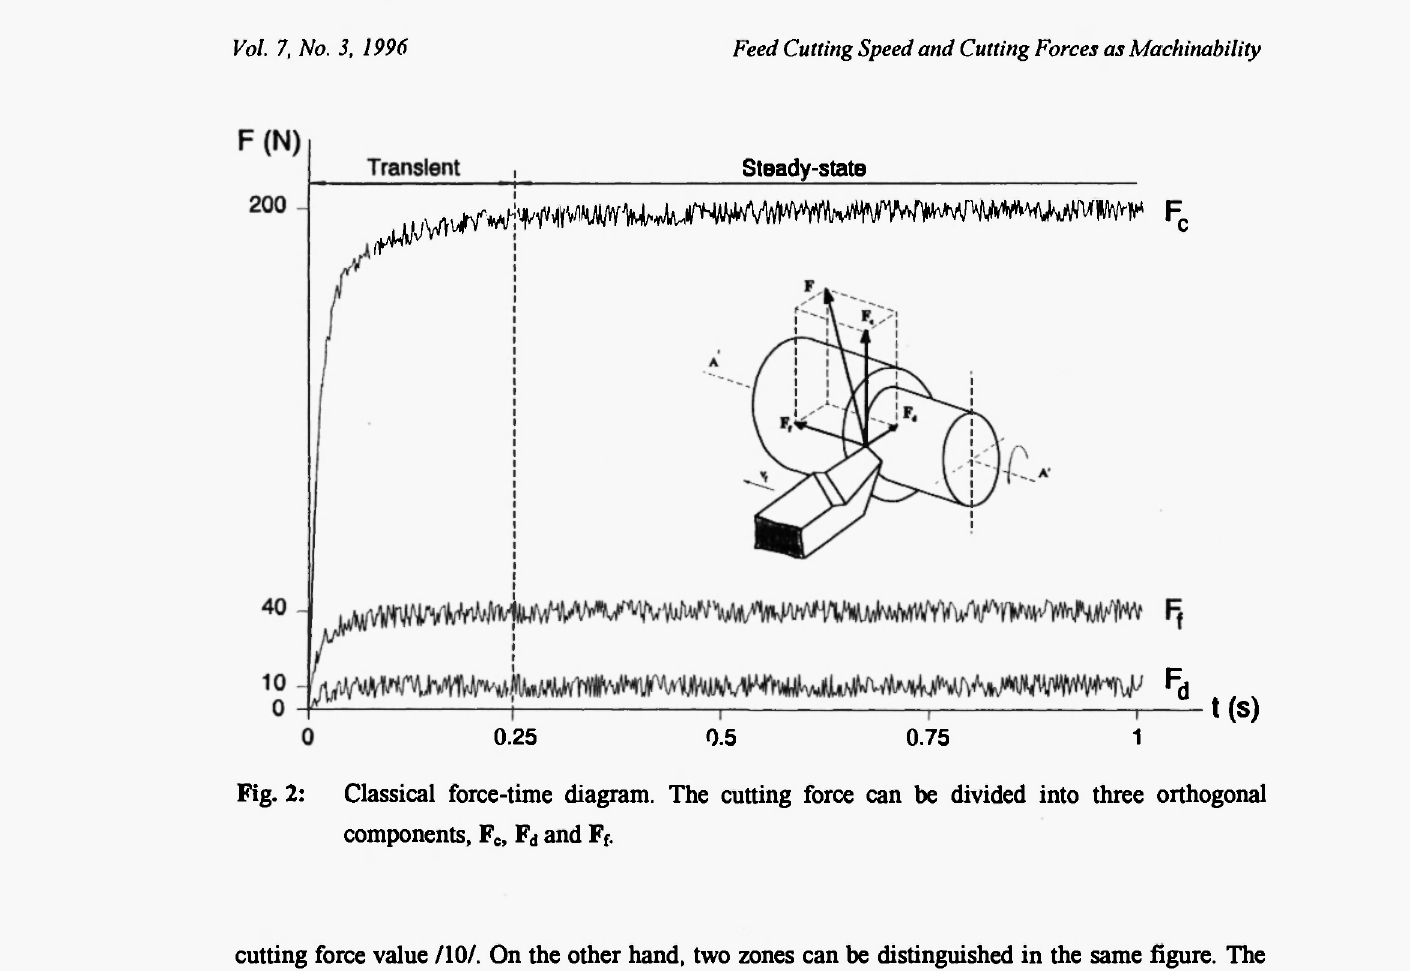
Fig. 2: Classical force-time diagram. The cutting force can be divided into three orthogonal components, F , F and F c d f